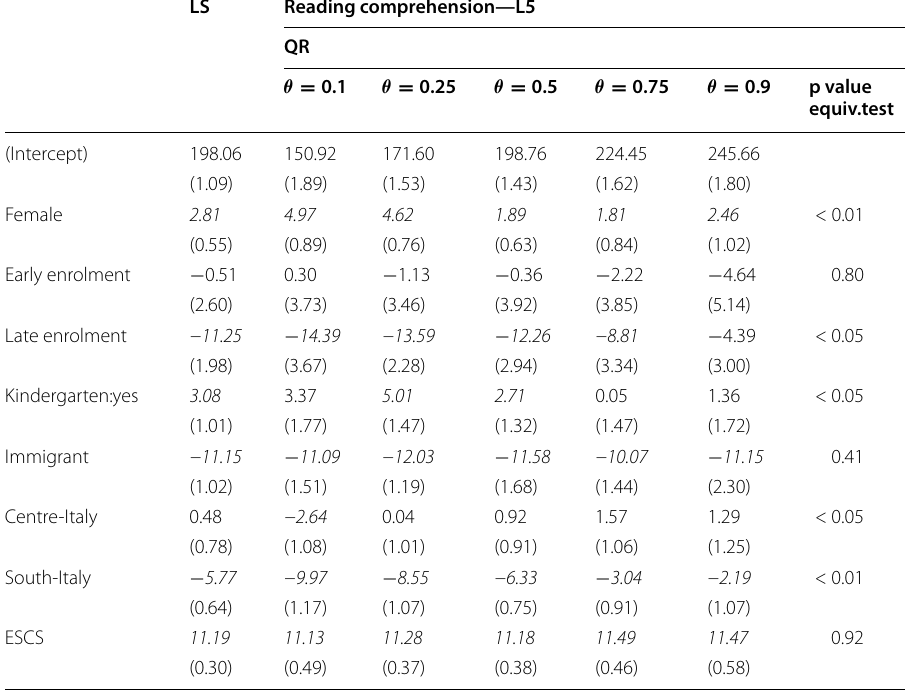
Table 4 LS and QR estimates of the effects of covariate on reading comprehension—fifth